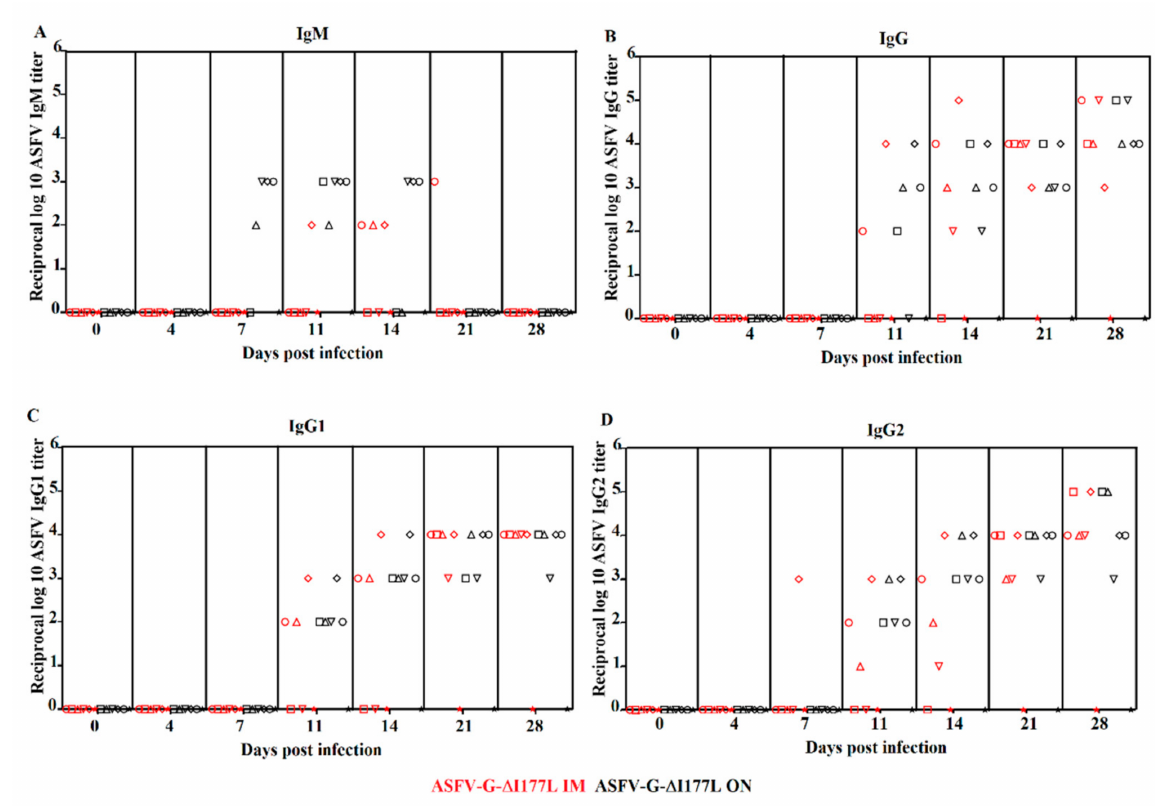
Figure 4. Anti-ASFV antibody titers detected by ELISA in pigs oronasally (ON) or intramuscularly (IM) inoculated with ASFV-G- ∆ I177L. Individual serum ASFV-specific antibody titers (indicated by individual symbols) mediated by IgM, total IgG, IgG1 and IgG2 are represented in panels ( A ), ( B ), ( C ) and ( D ), respectively. Titers are expressed as the log 10 of the reciprocal of the highest dilution of sera at least duplicating OD readings of a pool of mock-infected